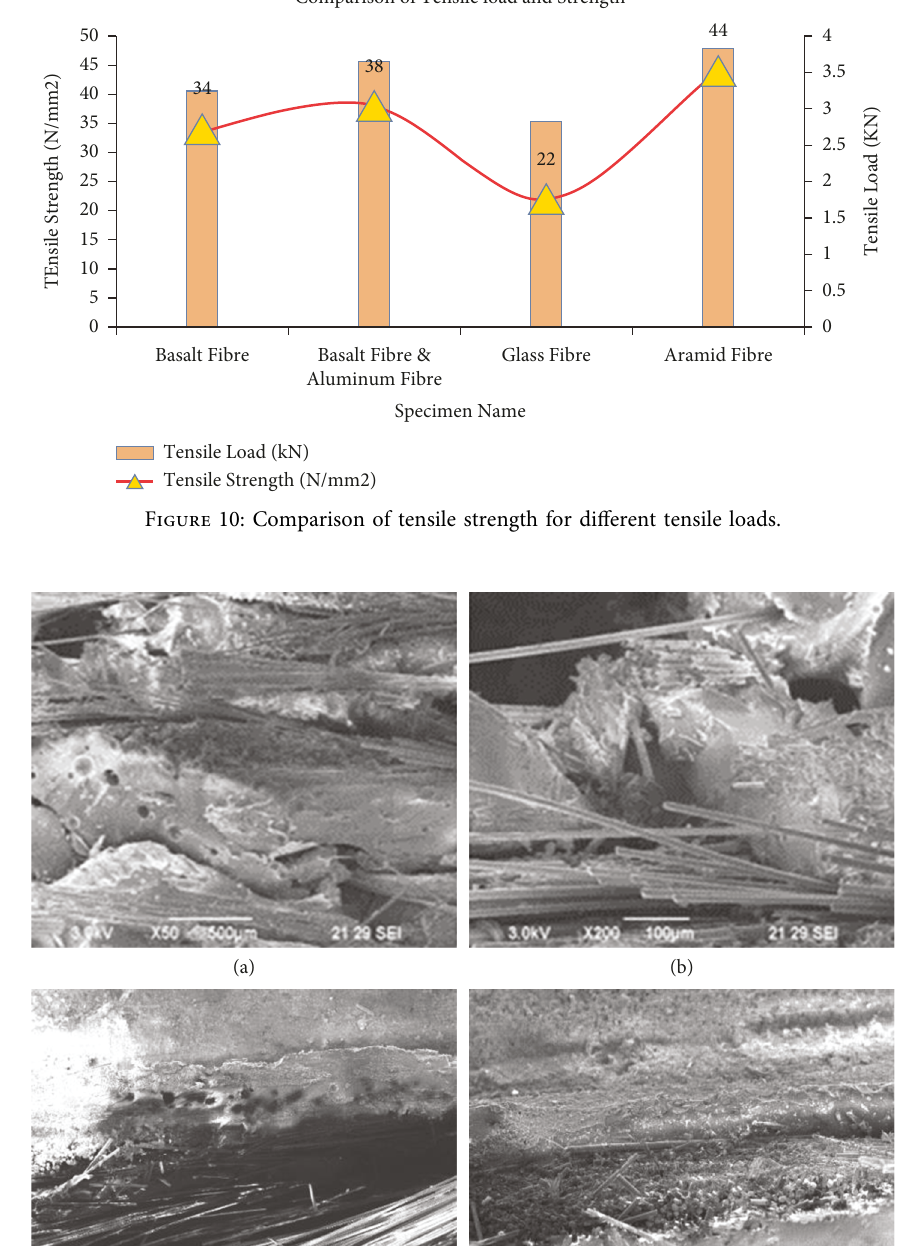
strength. The blue smooth line curve represents the tensile strength, and the red-lined yellow bullets depict the flexural strength. Figure 9 depicts the intermittent coincident be- tween tensile and flexural strength.